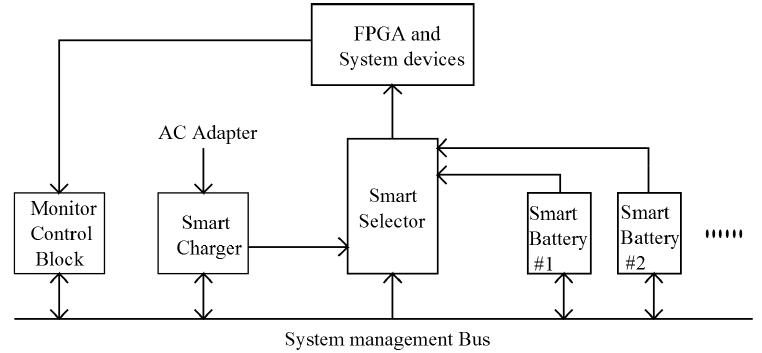
Figure 1. FPGA based smart battery management system diagram.